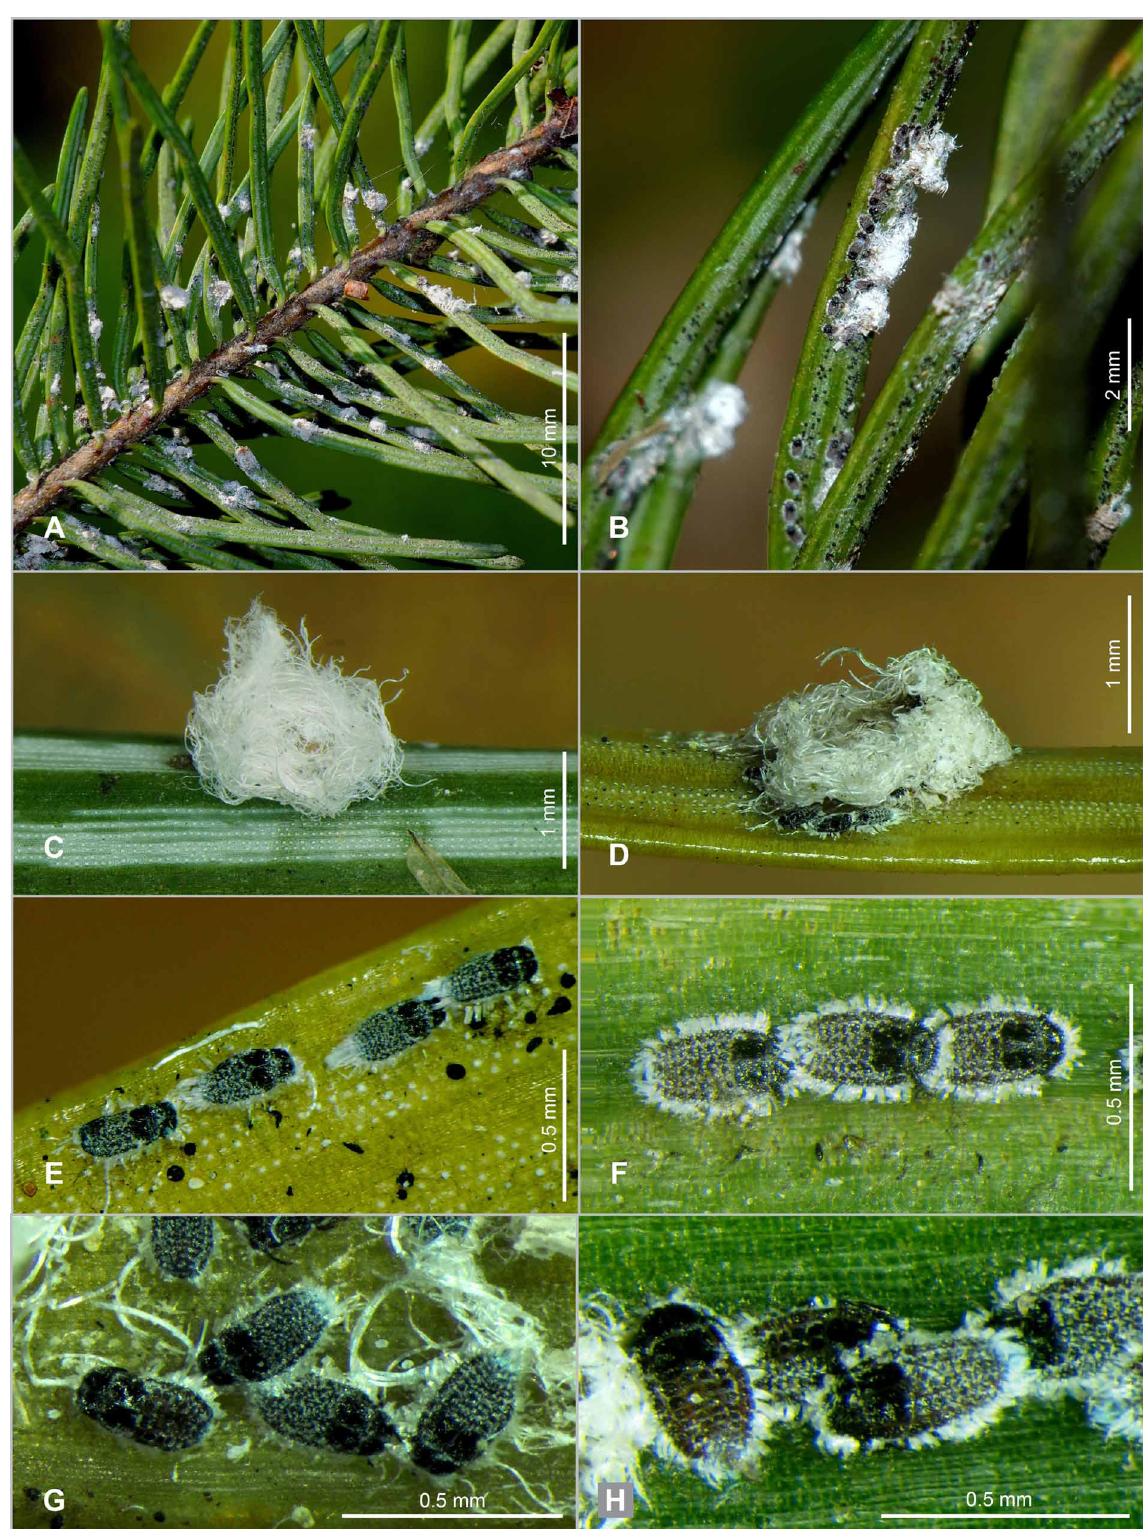
Fig. 70. Adelges (Gilletteella) cooleyi (Gillette, 1907). Apterae and neosistentes on needles of Pseudotsuga menziesii